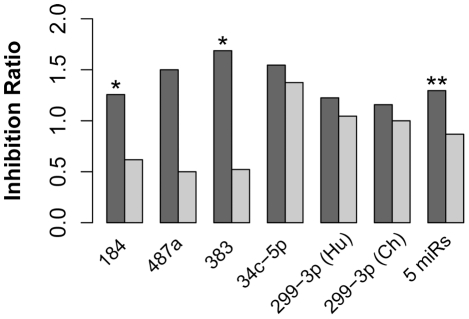
miRNA with human-specific expression showed negative association with expression of their target genes on the human evolutionary lineage.The dark grey bars depict the inhibition ratio of experimentally verified miRNA targets that showed human-specific expression on mRNA level in the prefrontal cortex. The light grey bars depict the inhibition ratio of the remaining targets of the same miRNA(s). Inhibition ratio was calculated as the number of genes showing opposite direction of expression divergence between human and chimpanzee brains, compared to that of the corresponding miRNA, divided by number of genes not showing this inverse expression divergence relationship. Experimentally verified miRNA targets were screened based on miRNA transfection experiments in two neuroblastoma cell lines (Materials and Methods). The significance of the inhibition ratio difference between miRNA targets with human-specific expression and miRNA targets with no human-specific expression were estimated using Fisher's exact test. The test significance is shown above the bars: *** - p<0.001; ** - p<0.01; * - p<0.05.